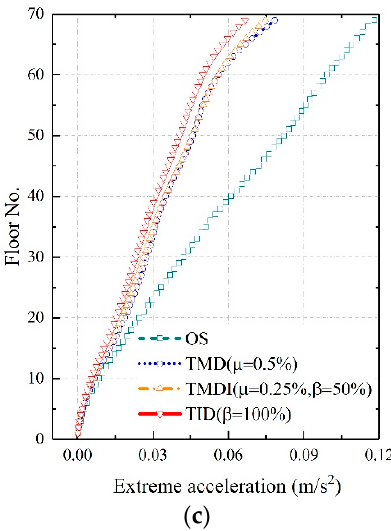
Figure 17. Profile of extreme wind-induced acceleration response at the x -axis along the building height corresponding to three different wind directions: ( a ) 0° wind direction; ( b ) 45° wind direction; ( c ) 90° wind direction.